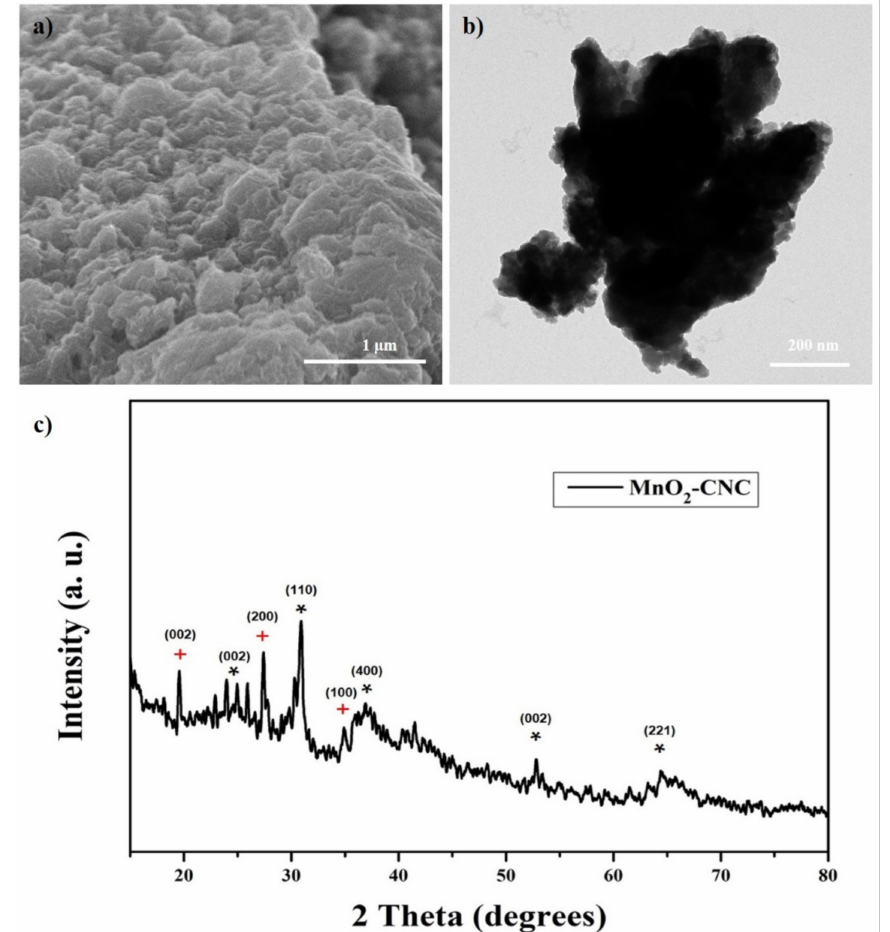
Figure 11. ( a ) SEM, ( b ) TEM and ( c ) XRD patterns of MnO 2 -CNN composite electrodes after 1000